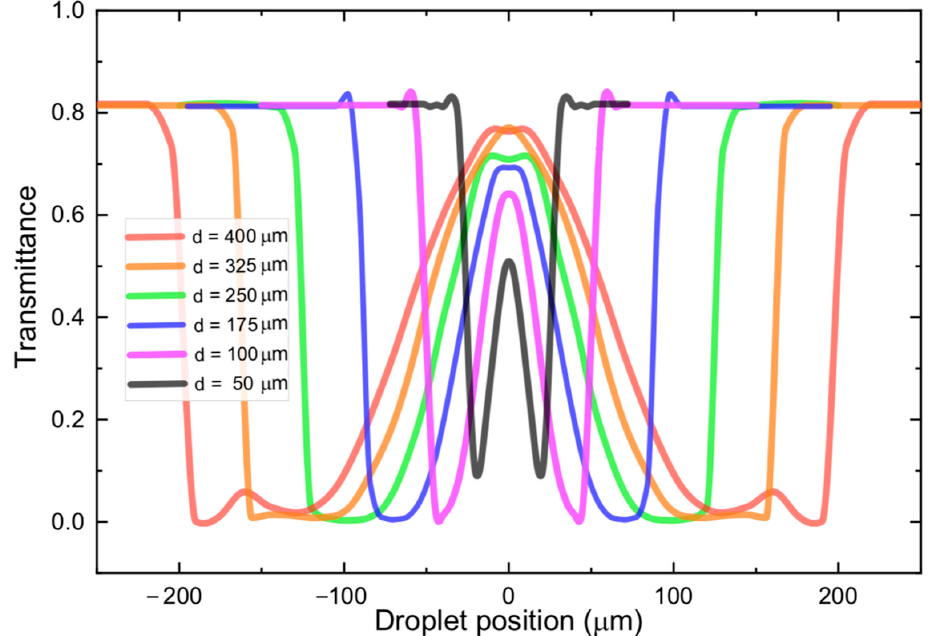
Figure 5. Modelled transmittance as a function of droplet position. Droplet position 0 µm, corre- sponds to the situation in which the beam of light is going straight to the middle of the droplet. The six different curves correspond to droplets with diameters ranging from 50 µm (black) up to 400 µm (red).